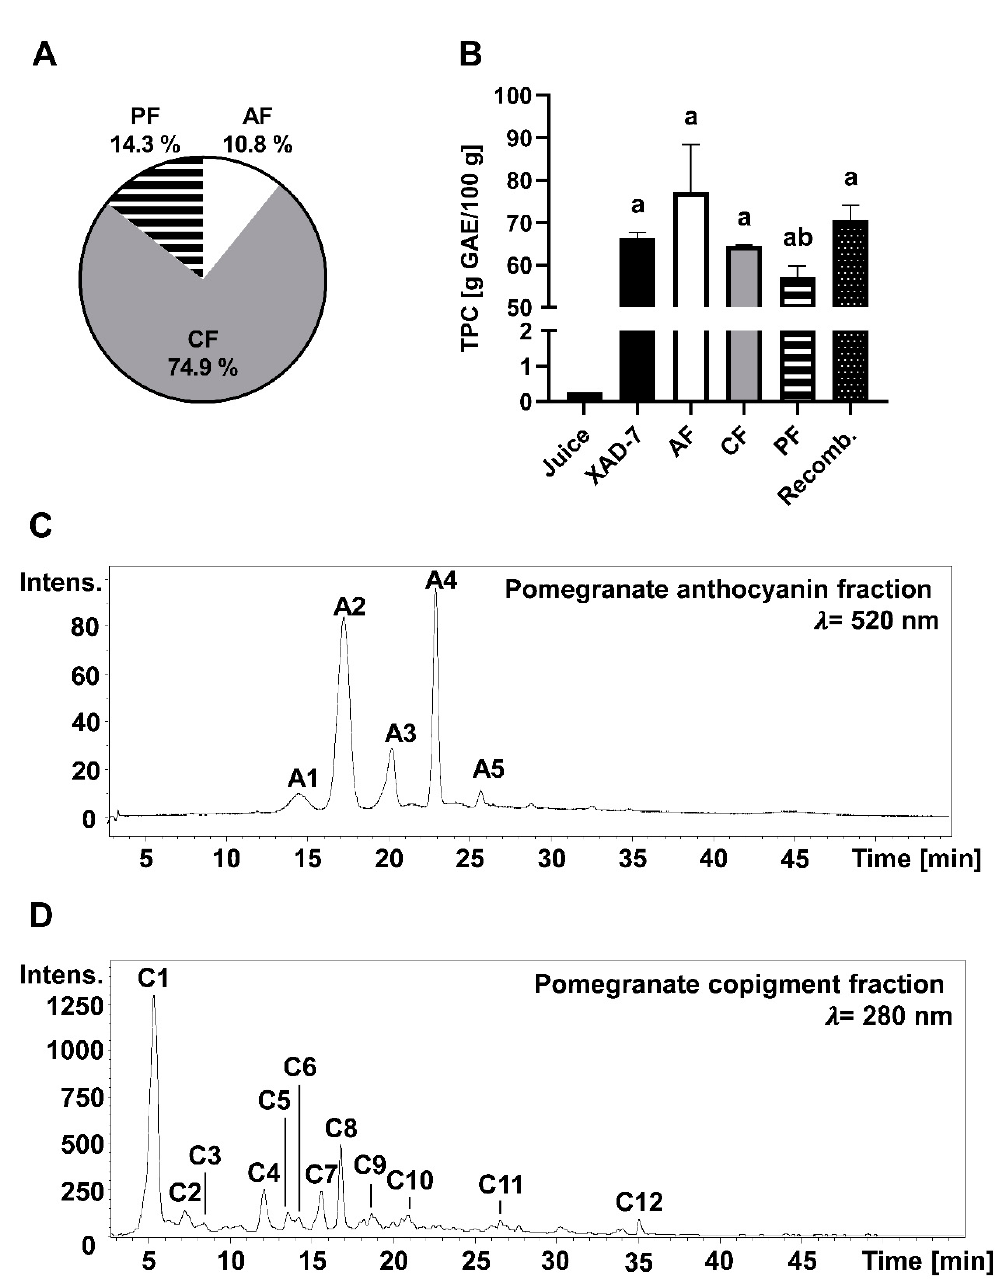
(Figure 2B). After recombining the monomeric and polymeric fractions according to the analyzed composition, we achieved the TPC content of the pomegranate XAD-7 extract.